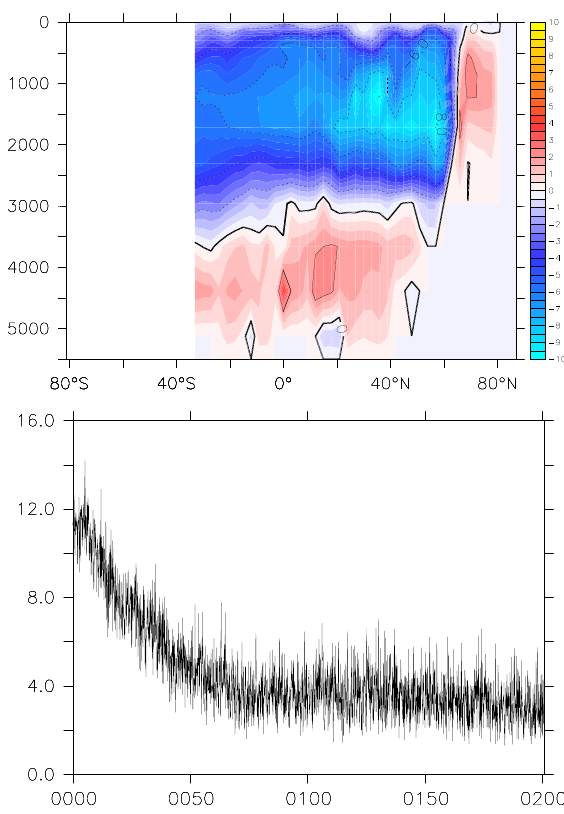
Fig. 22. The difference of the Atlantic meridional overturning stream function between the 2 × CO 2 experiment and the control run (top) and the time series of the maximum AMOC strength in the 2 × CO 2 experiment (bottom), both in Sv .